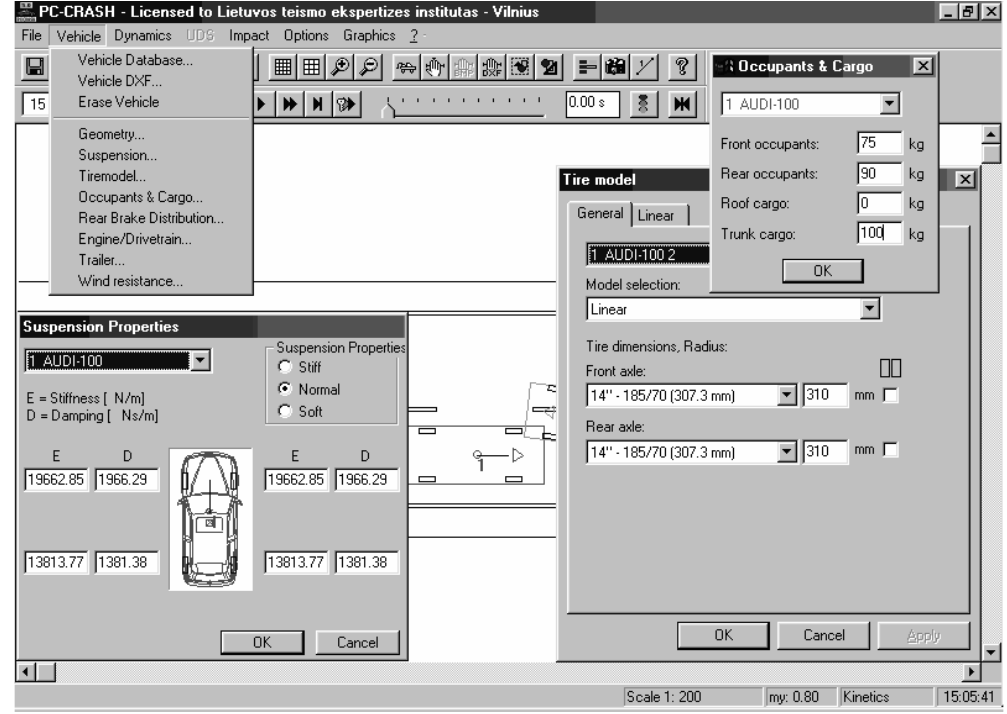
Fig 3. The general view of the screen while modeling with the help of the program PC CRASH (the parameters of the automobile, which may be selected, are